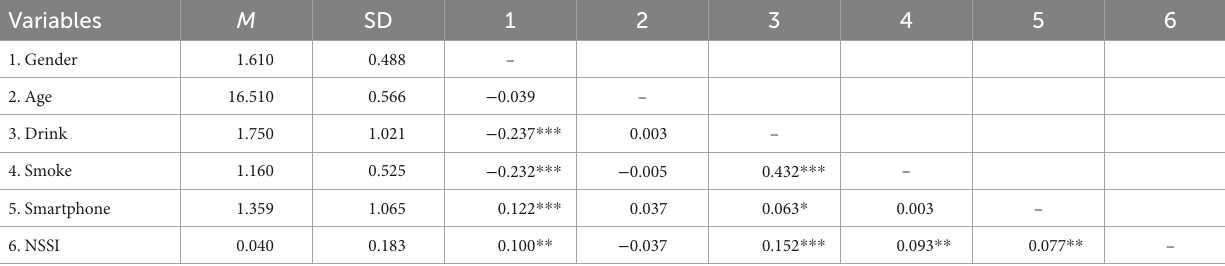
TABLE 1 Means, standard deviations, and correlations of the main study variables.